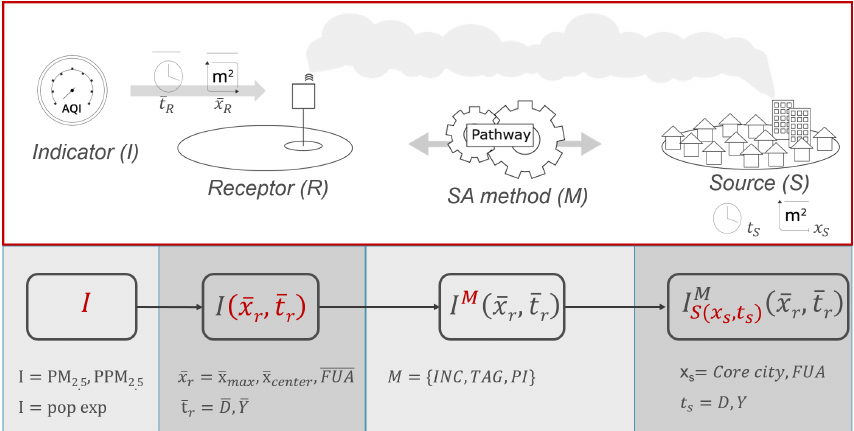
Figure 1. Schematic flow chart representing the four steps required to fully define any SA process. The red letters indicate the indicator characteristic under consideration. The general notation for the indicator ( I ) includes a superscript for the methodological approach ( M ), a subscript to inform about the source ( S ), and brackets to inform about the receptor ( R ). The spatial and temporal dimensions associated with the source and receptor are denoted by “ x ” and “ t ”, respectively. The overbar indicates an averaging process. The lowest row provides for each parameter examples used in this work. Some images used in this schematic flow chart are adapted from https://www.flaticon.com/ (last access: 24 November